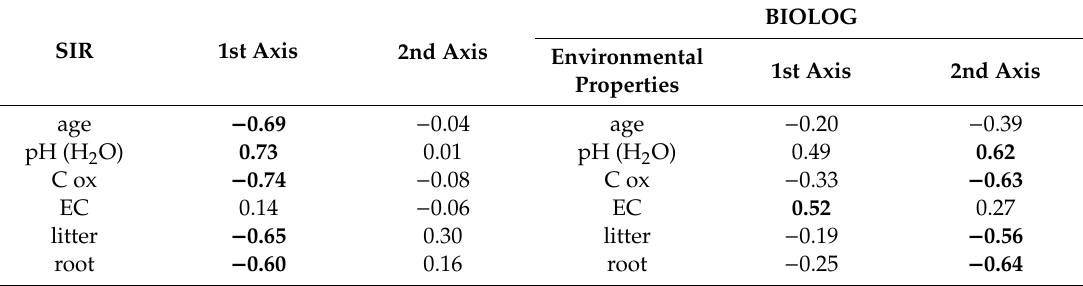
Table 3. Correlation between each parameter and 1st and 2nd axis of PCA analysis results in each method. Bold and black characters are statistically significant. age: site age, C ox: oxidizable carbon, litter: litter mass, root: root